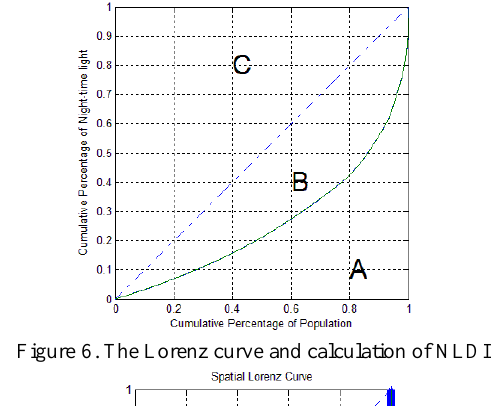
Figure 6. The Lorenz curve and calculation of NLDI